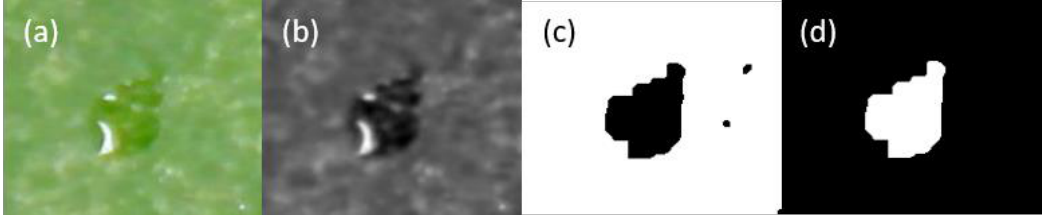
n θ = pixel amount of the standard card.